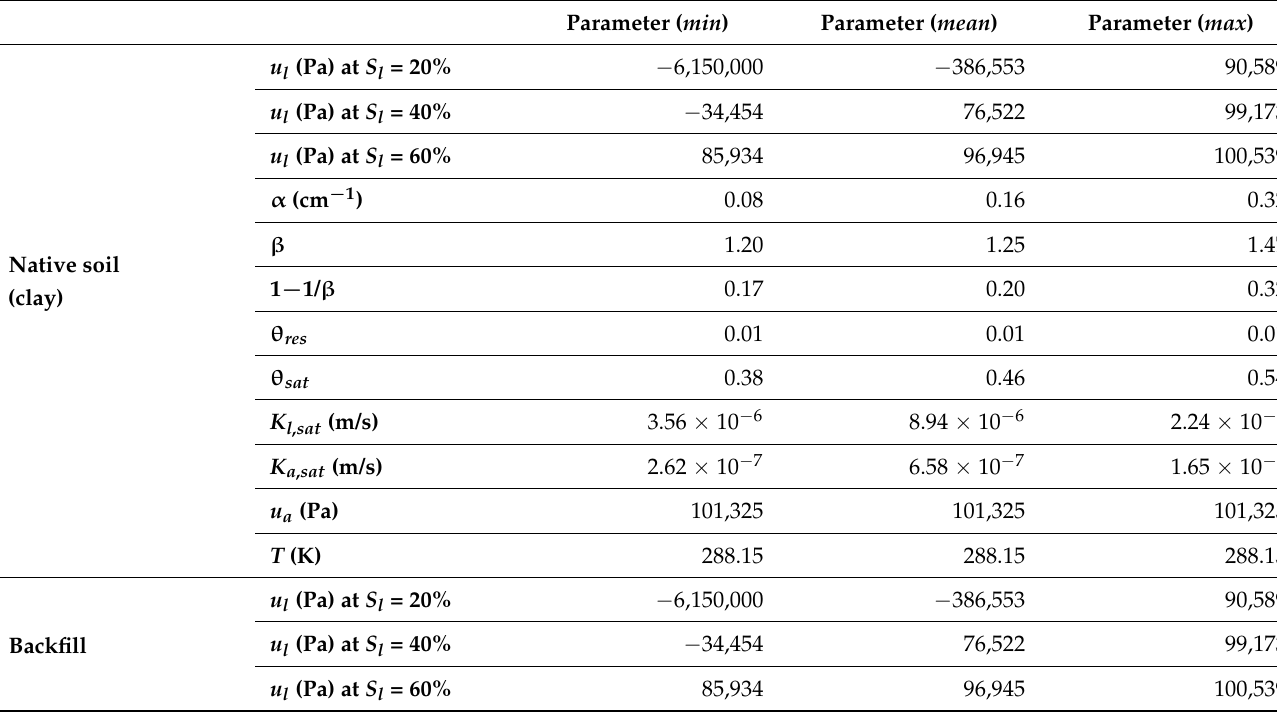
Table 7. Initial input for batch simulation of LT location (adopted from